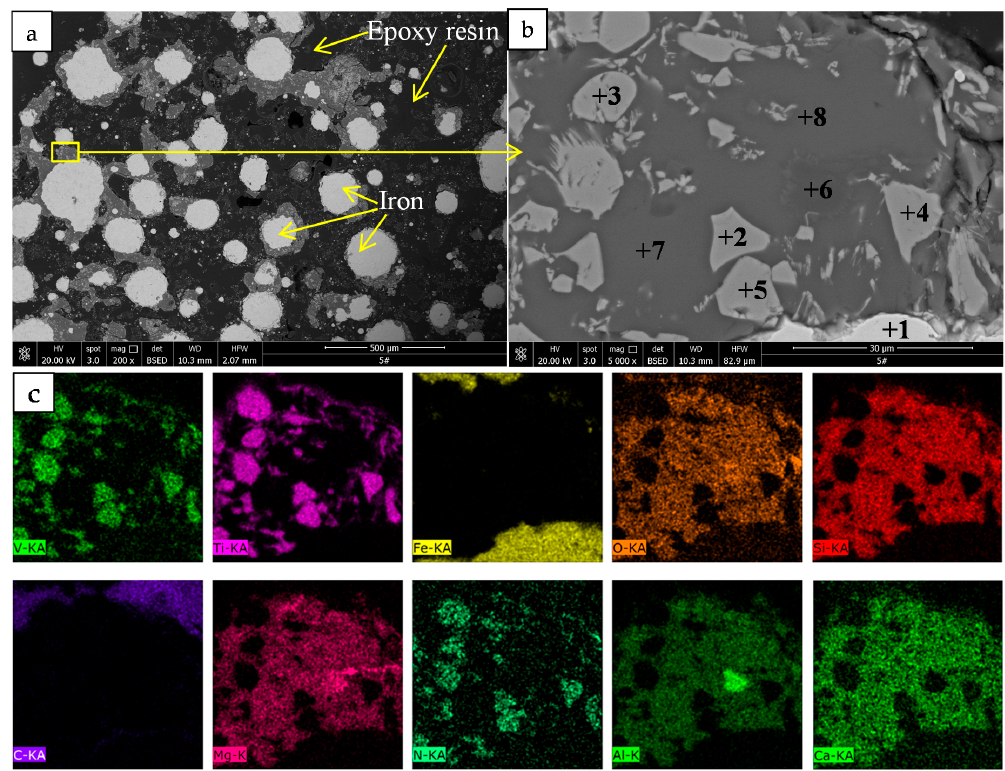
Figure 5. SEM images and elemental surface scanning images of the pellets with 26 wt % coal reduced at 1300 °C for 90 min: ( a ) SEM images (200×); ( b ) partial enlarged view of the ( a ) (5000×), “+” refer to analyzed point by EDS, numbers refer to composition data in Table 4; ( c ) elemental surface scanning images of the area showed in ( b ), K and KA are electron orbital labels. Table 4. Chemical composition of points indicated in Figure 5b (wt %).